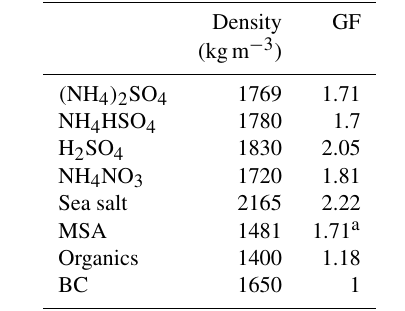
Table 1. Density and GF (at 90% RH) of chemical species used in the closure